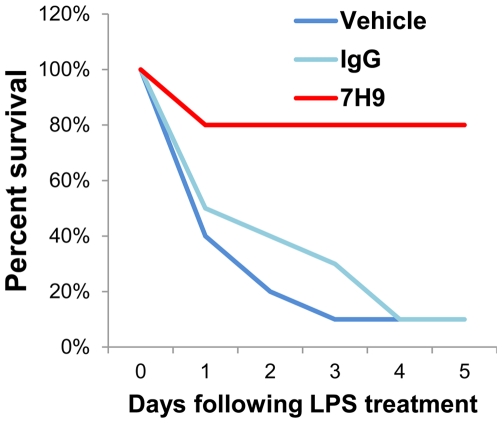
7H9 prevents lethality caused by LPS administration.Survival curve of mice treated with LPS (8 mg/kg, i.p.) on day 0. Mice were pre-treated with vehicle (PBS), IgG (normal mouse IgG), or 7H9.